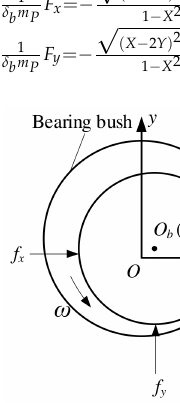
Figure 2. Axial diameter force diagram of sliding bearing [25]. The parameters in Equation (1) are in Appendix